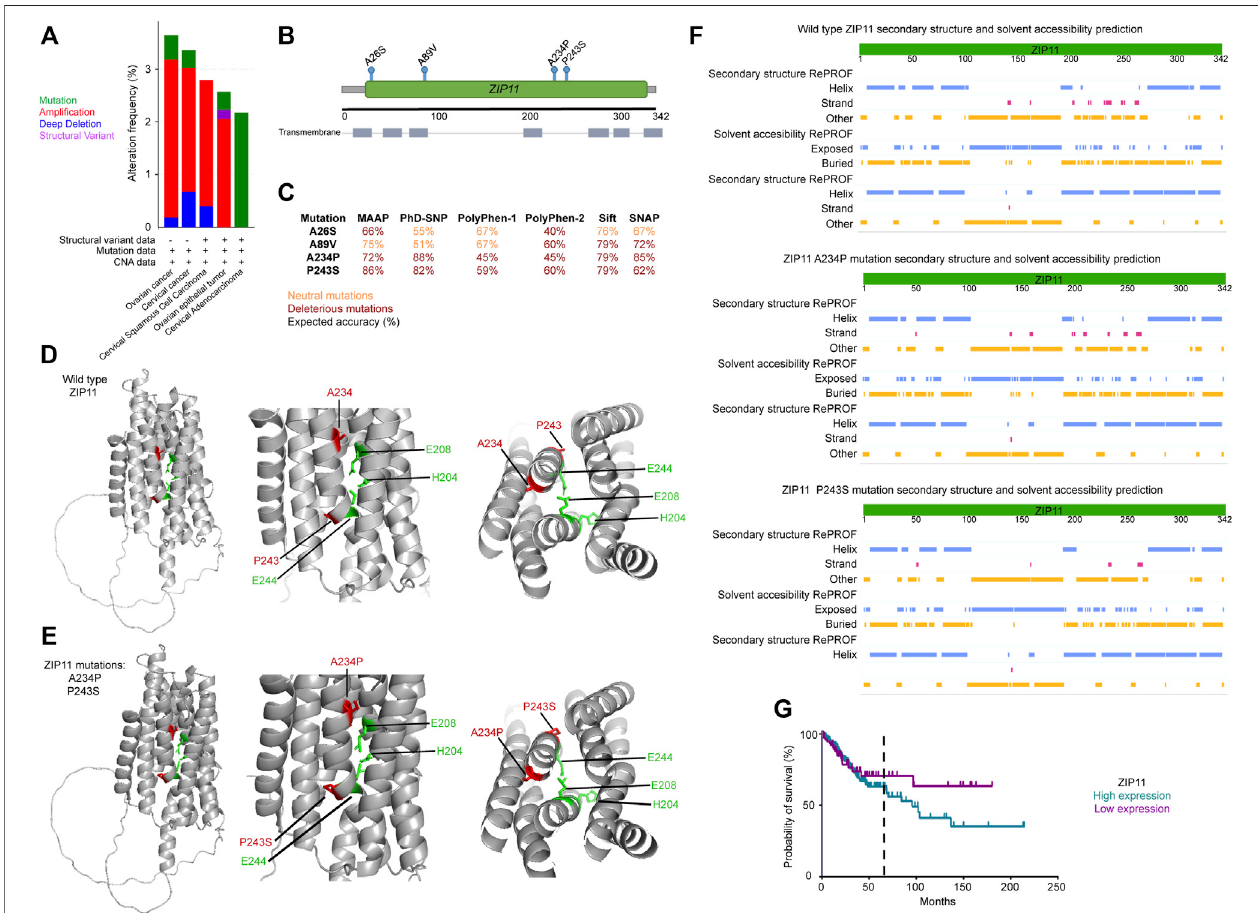
FIGURE1 | ZIP11 rolein the progression of cervical and ovarian cancer. (A) Analysisof 2344samples from 2330patientsfound in seven publiclyavailable cervical and ovarian cancer studies (https://www.cbioportal.org/) con fi rmed that ZIP11 had an alteration frequency of 2 – 3%, within the genome. (B) Schematic of ZIP11 and SNP locations (green) within the ZIP11 protein and transmembrane domains (gray). (C) PredictSNP analysis of ZIP11 SNPs in cervical and ovarian cancer (red = deleterious; orange = neutral mutations). Representative model of wild type ZIP11 (D) and ZIP11 containing two deleterious SNPs (A234P and P243S, (E) within the substrate binging region. (F) In silico modeling with PredictProtein calculated that ZIP11 may have increased substrate accessibility when the two deleterious SNPs (A234P and P243S) are introduced. (G) Kaplan-Meier survival curve using a cervical cancer data set containing 291 patients. Five-year survival indicated by black, vertical, dashed line. The statistical information for the comparison of survival curves can be found in Supplementary Table S3 .